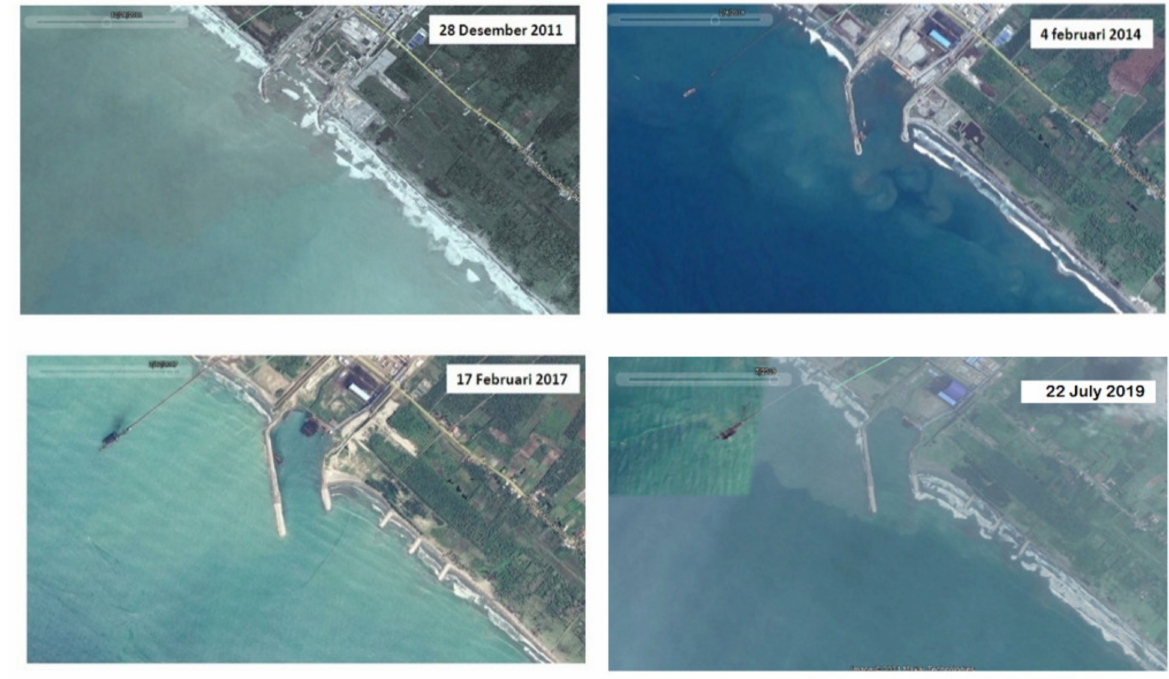
Figure 5. Historical coastline changes